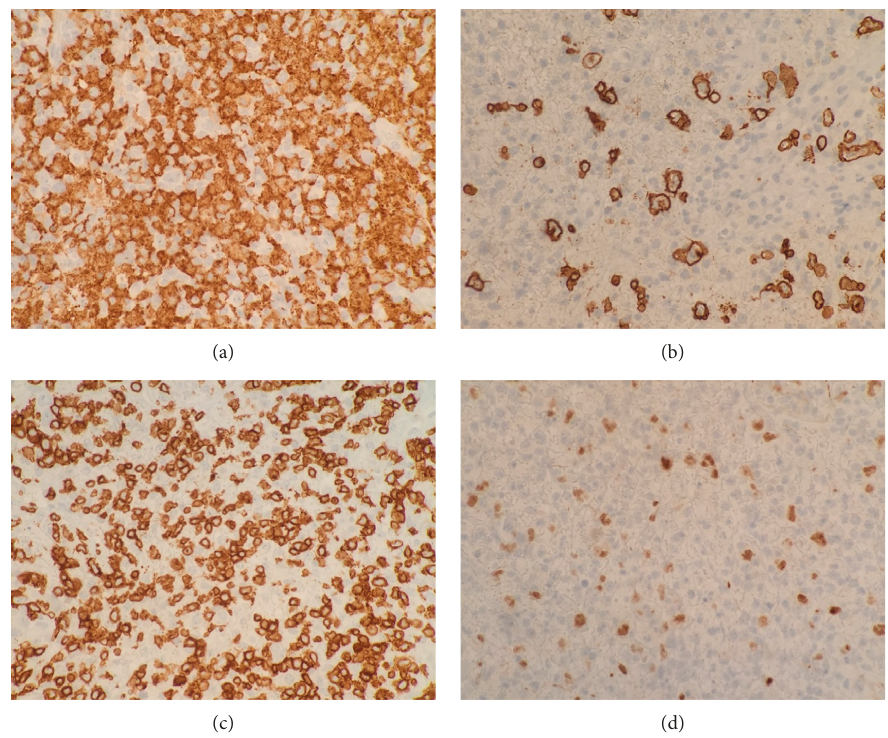
Figure 2: (a) CD3 stain at 40x highlighting the T-cells. (b) PAX5 stain at 40x highlighting the B-lymphocytes. (c) CD20 stain at 40x highlighting the background large B-cells. (d) CD163 stain at 40x highlighting the